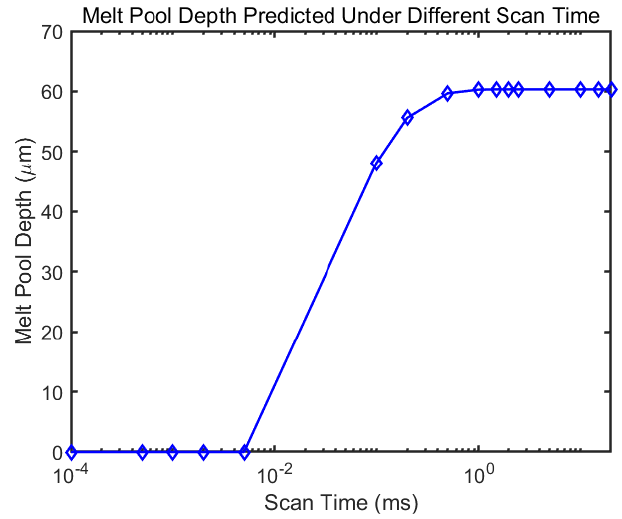
Figure 13. The predicted melt pool depth evolution with continuous scan time.